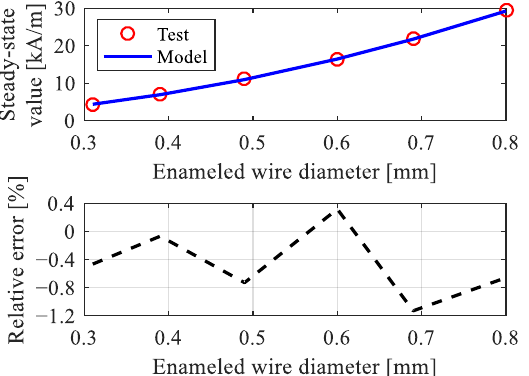
( f ) Figure 9. The dynamic magnetic field under square-wave input: ( a ) D wire = 0.31 mm; ( b ) D wire = 0.39 mm; ( c ) D wire = 0.49 mm; ( d ) D wire = 0.60 mm; ( e ) D wire = 0.69 mm; ( f ) D wire = 0.80 mm. 3.3.2. Steady-State Value and Response Time The steady-state value and response time are the most important characteristic pa- rameters of the on – off-type actuator. When the square-wave voltage maintains a high